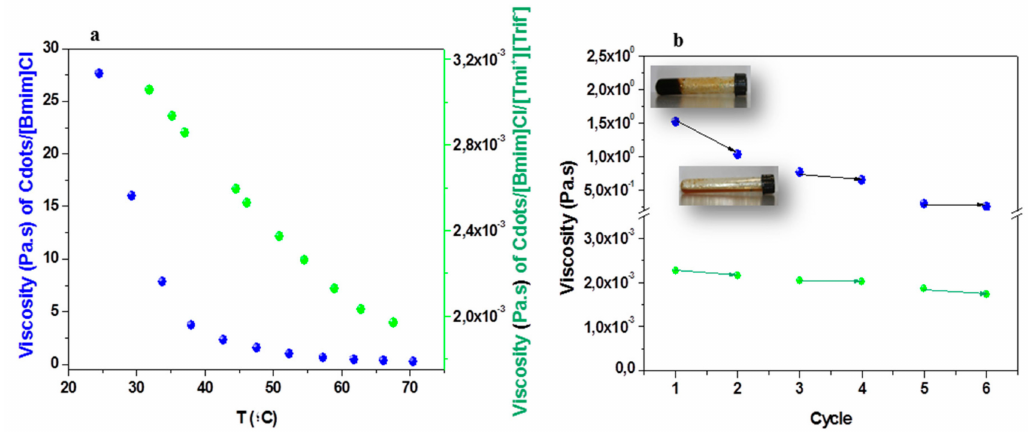
Figure 4. ( a ) Viscosity profile of the nanofluids in pristine state and ( b ) viscosity values obtained at 50 ◦ C after each heating and cooling cycle for Cdots / [Bmim]Cl in blue and Cdots / [Bmim]Cl / [Tmi + ][Trif − ] in green. Inset: images of Cdots / [Bmim]Cl before the first heating cycle and upon